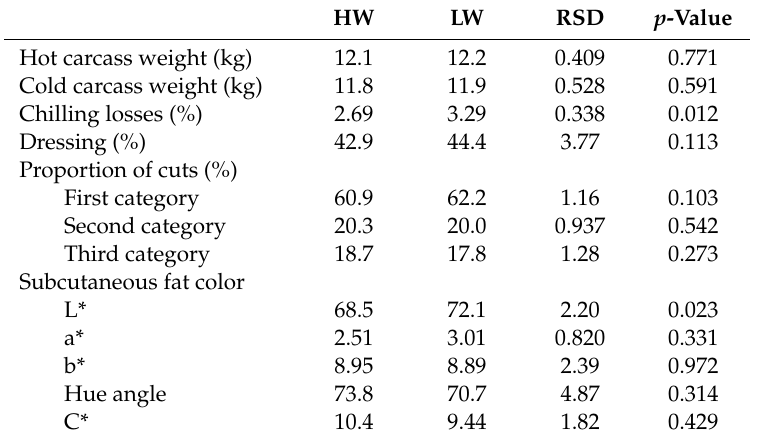
Table 3. Carcass characteristics of fattening lambs born with high (HW) or low weight (LW).